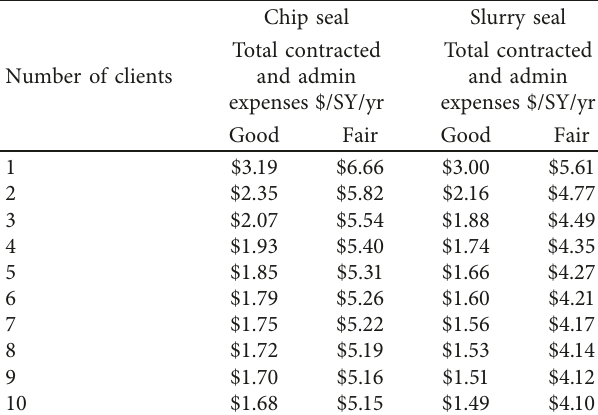
Table 5: The total annual cost of slurry and chip seal in different pavement